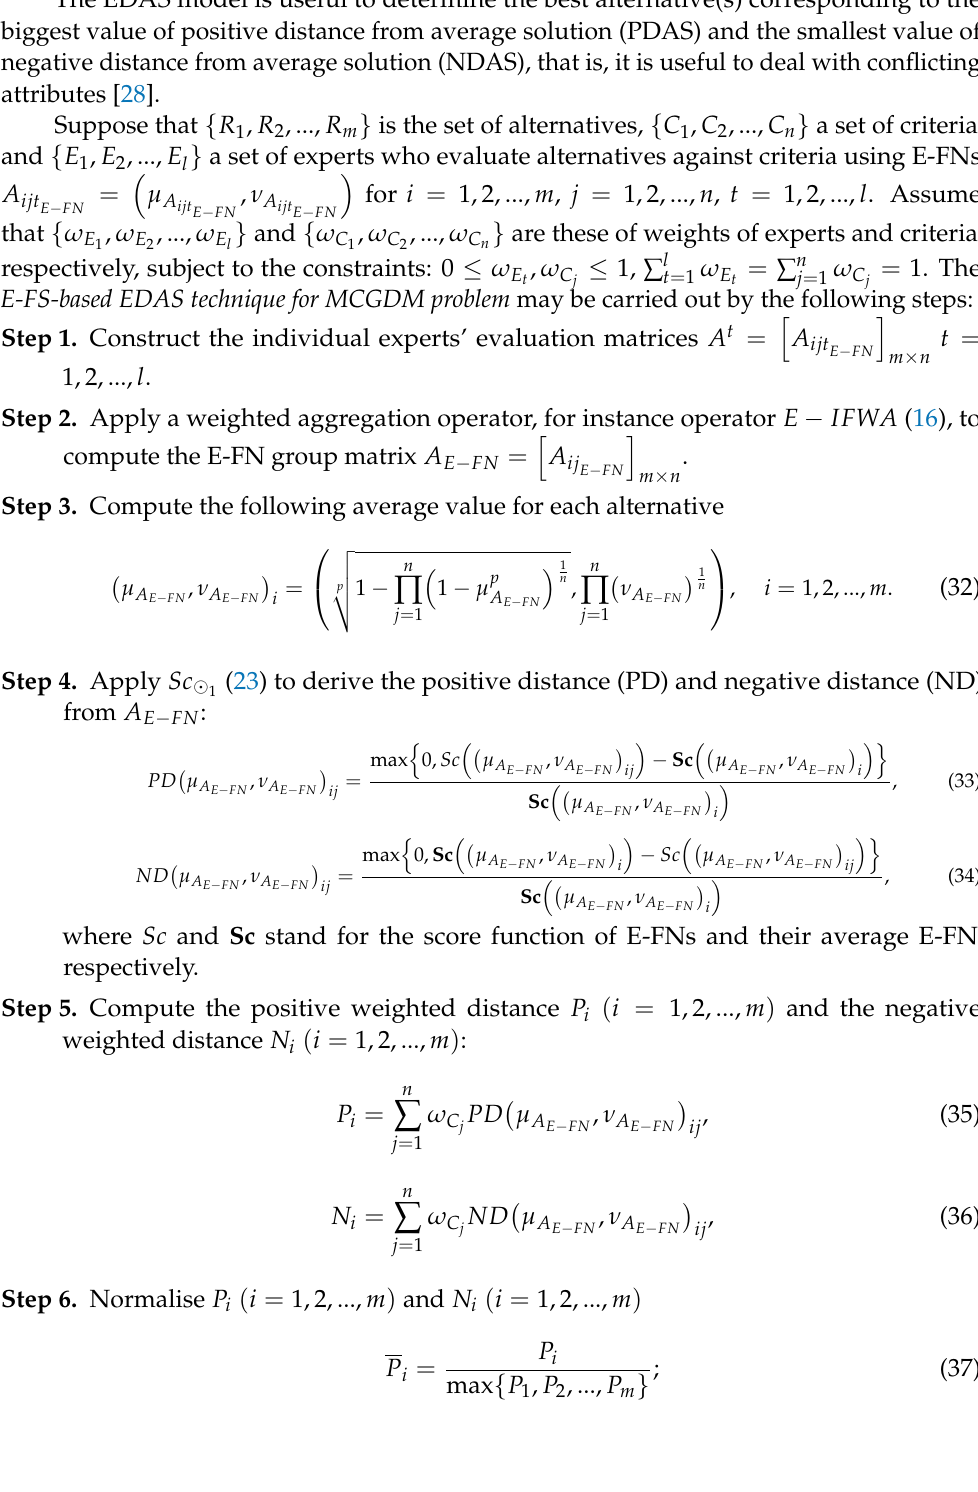
Table 5. The ranking of A = ( 0.9,0.8 ) and B = ( 0.2,0.2 ) as E-FSs with new score function. Sc FC ( λ ) A –Score B –Score Ranking Sc FC ( λ = 1 ) 0.18 0.16 A > B Sc FC ( λ = 1/2 ) 0.19 0.48 A < B Sc FC ( λ = 0 ) 0.2 0.8 A <